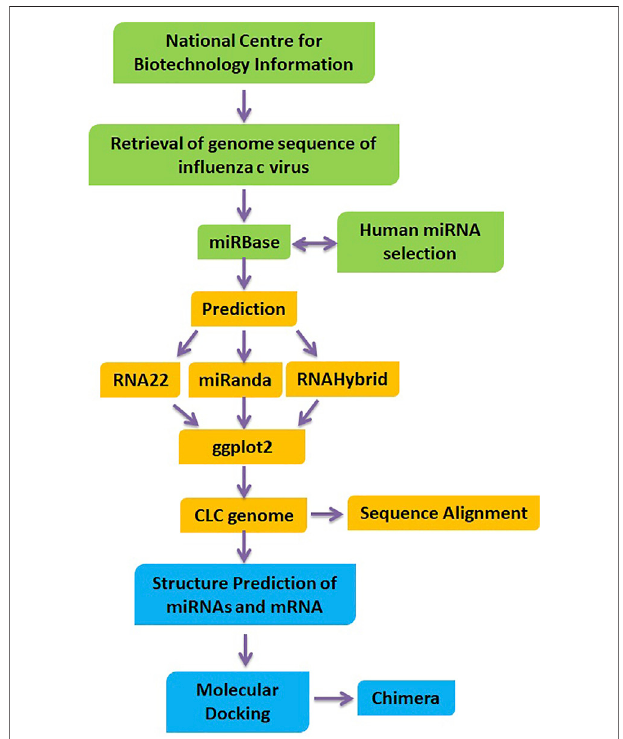
FIGURE 1 | Flow chart of designed research